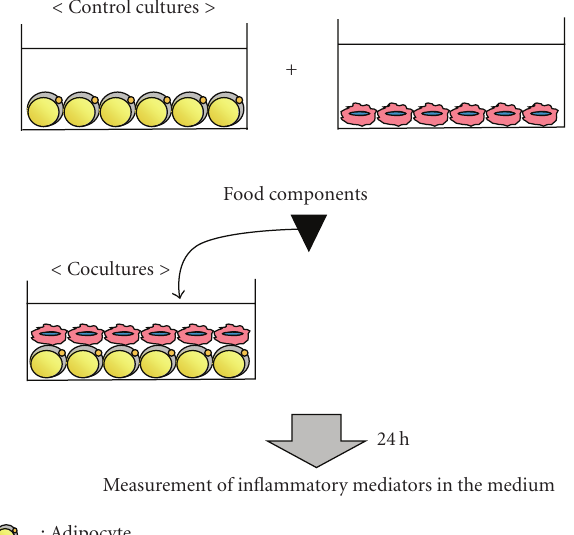
Figure 3: Coculture system of adipocytes and macrophages for the screening for anti-inflammatory food